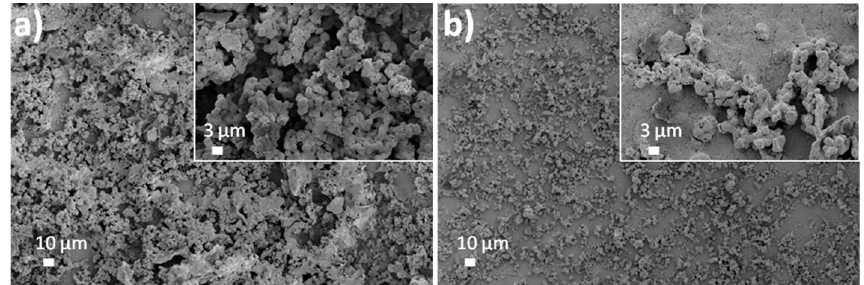
Figure 1. Field-emission scanning electron microscope ( FESEM) images of ZnO microparticle coatings deposited on ( a ) polylactic acid (PLA) and ( b ) polypropylene (PP) polymeric supports.